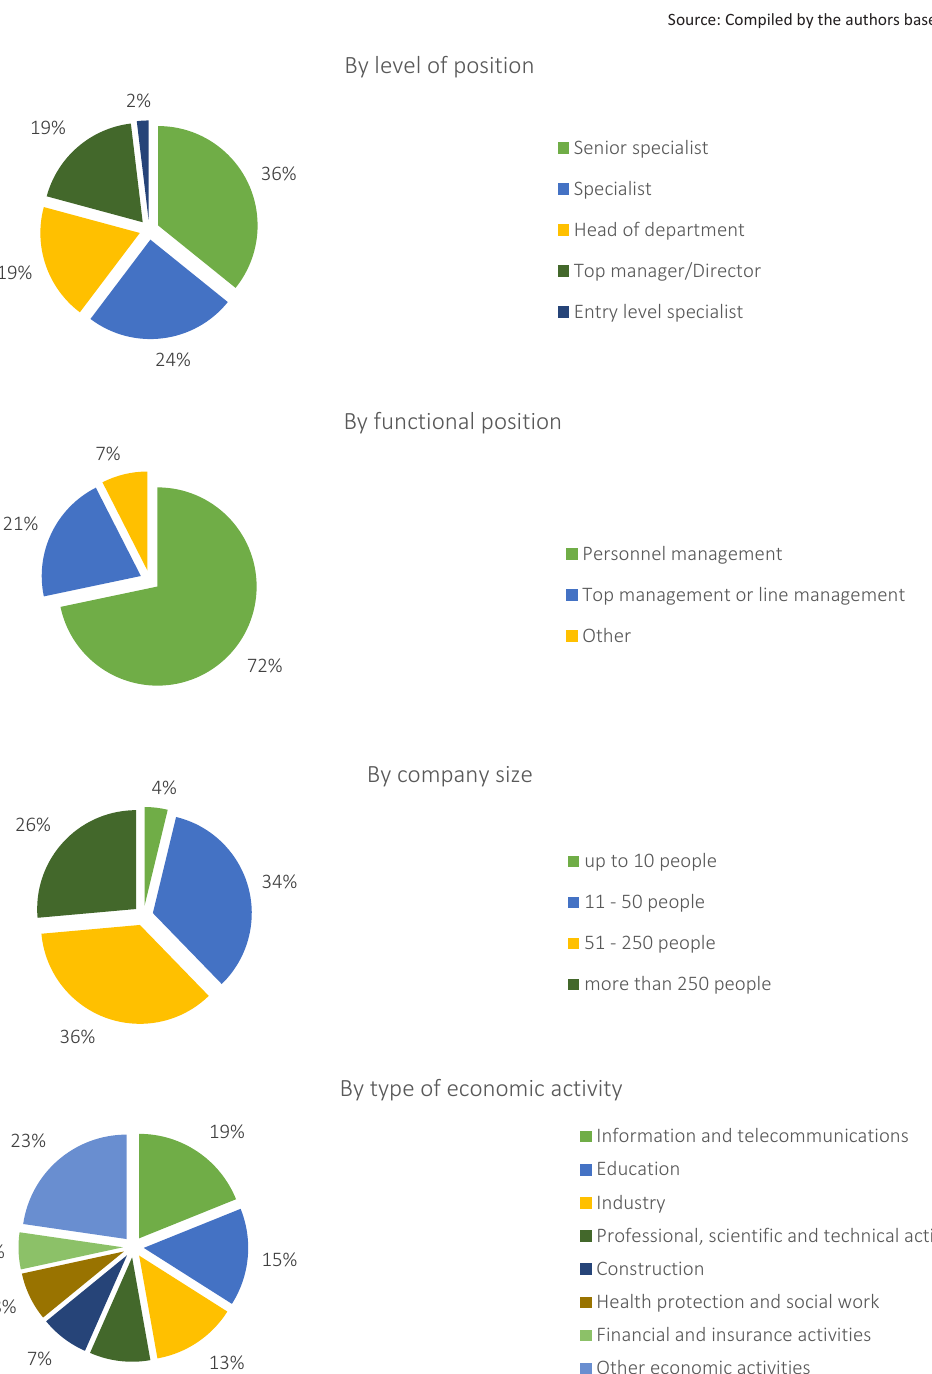
Figure 4. Characteristics of respondents of the expert